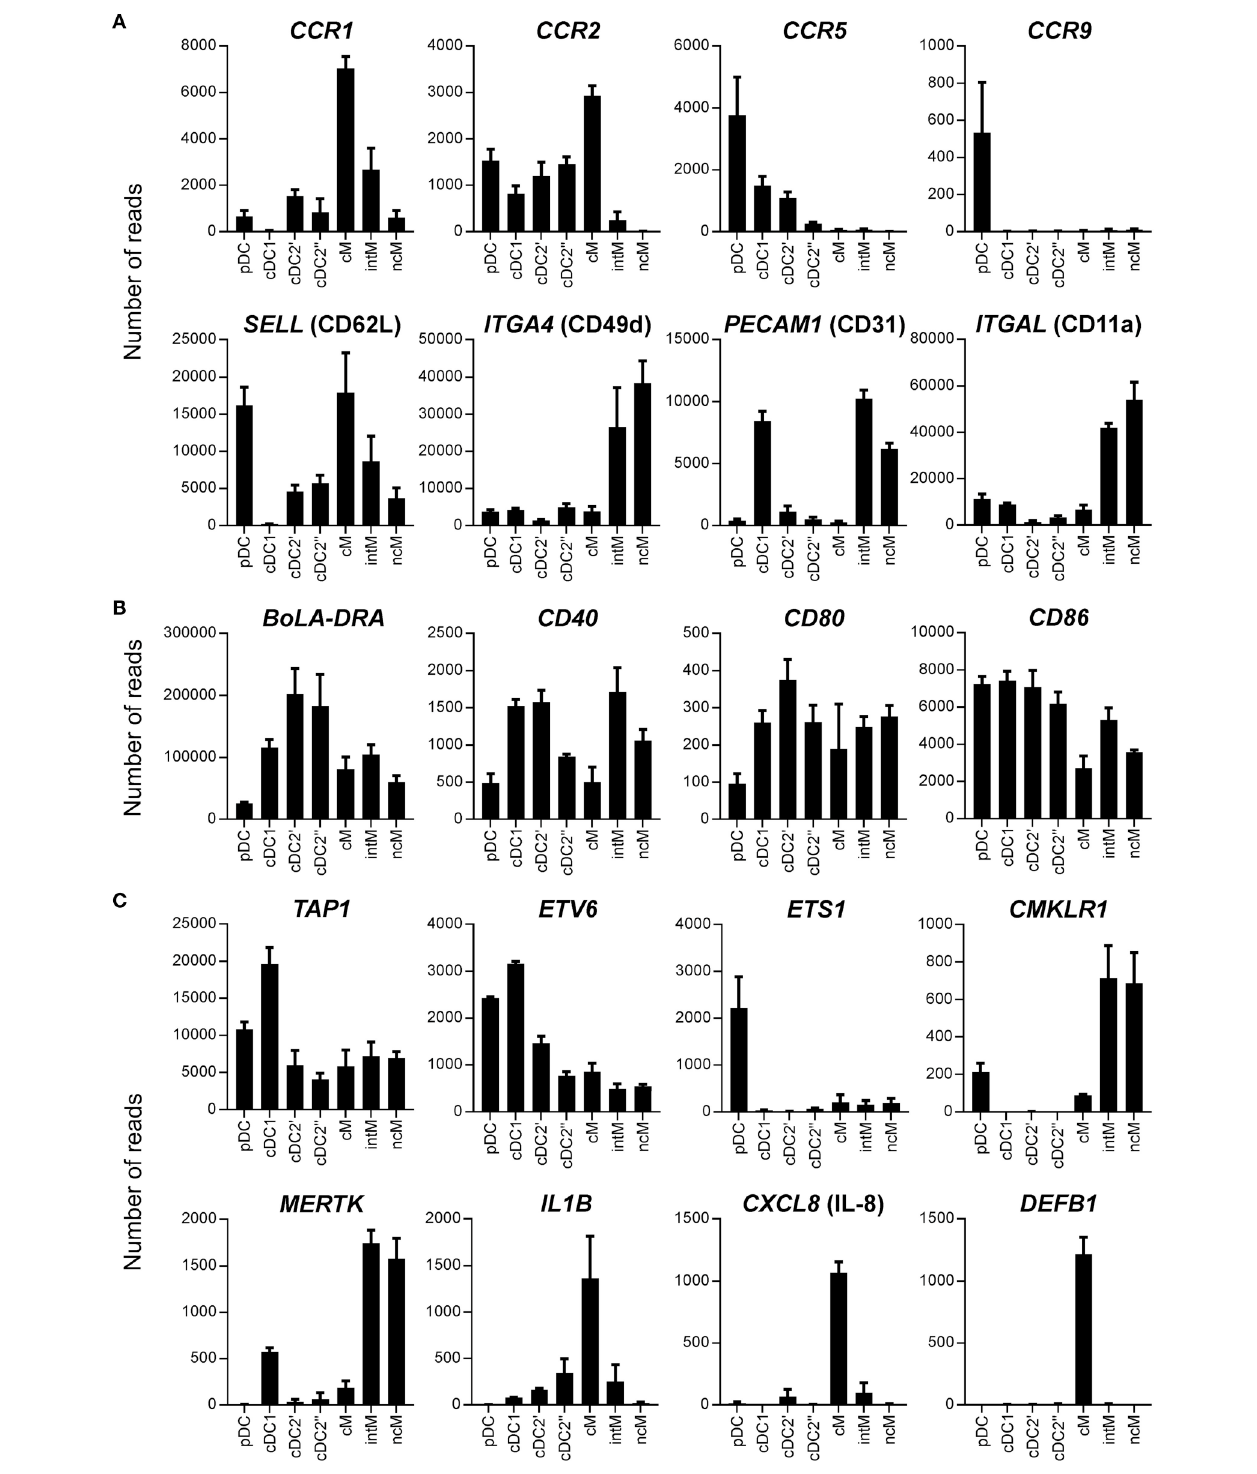
FIGURE 8 | Transcription of genes coding for chemokine receptors and adhesion molecules (A) , BoLA-DRA and co-stimulatory molecules (B) , and miscellaneous function-related molecules (C) . High-throughput sequencing was performed on RNA isolated from sorted DC and monocyte subsets. Mean number of normalized reads and SD is shown for three animals and selected